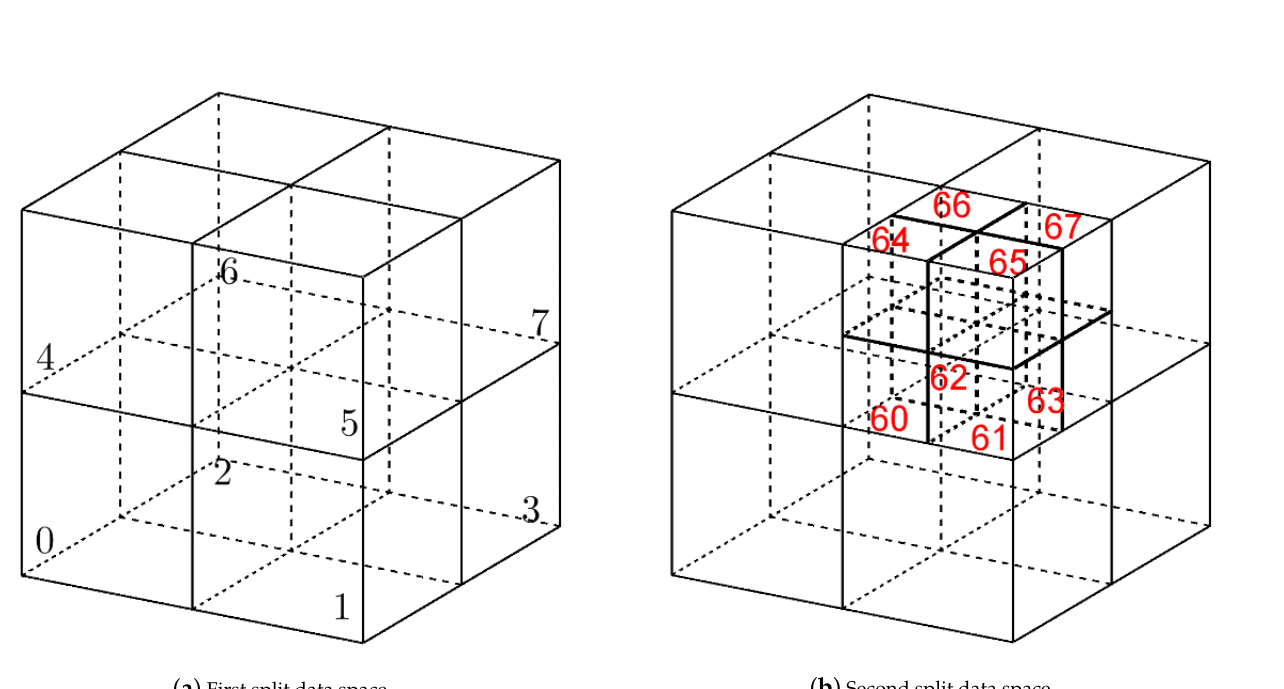
Figure 1. The process of octree splitting data space and encoding.